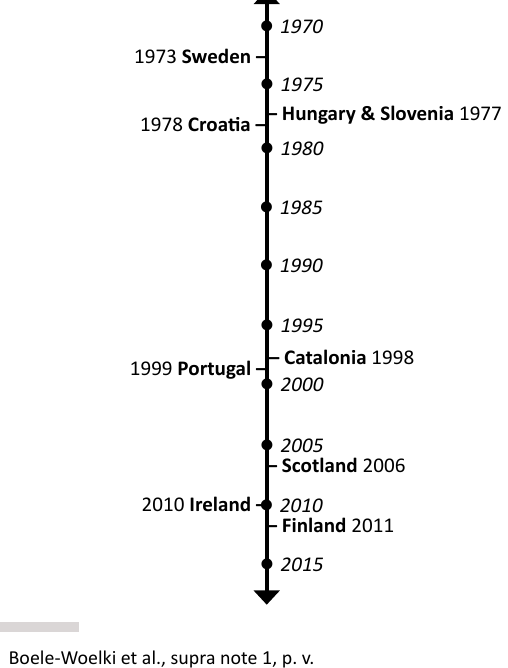
Figure 1 Timeline of regulation in the nine